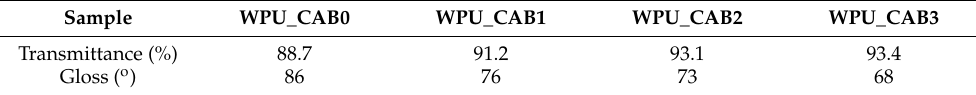
Table 5. Optical transmittance and gloss (60 ◦ ) of WPU films with different CAB